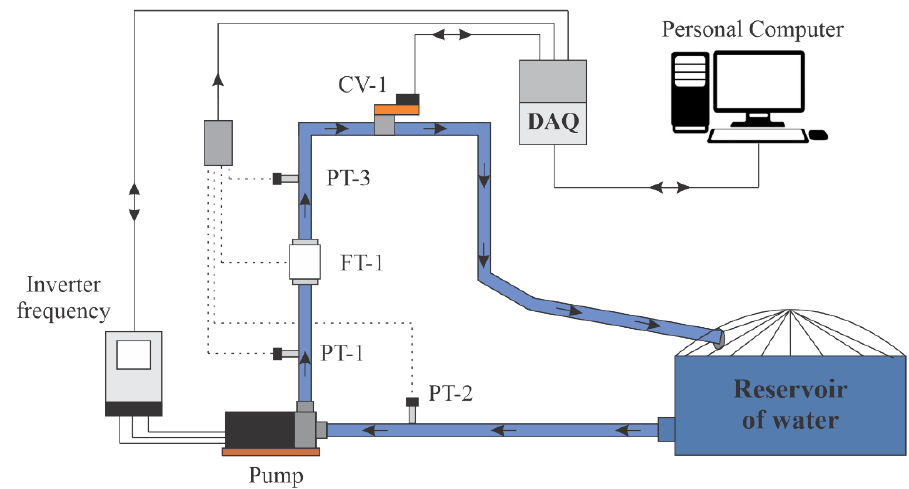
Figure 5. Bench schematic